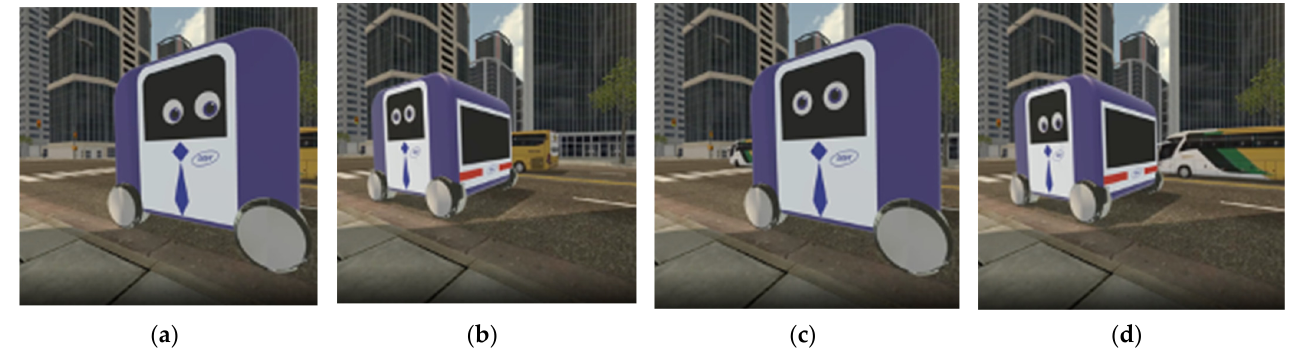
Figure 3. Design of videos within Scenario 2 ( a ) 2A: eye movement yes (1) and conversational distance